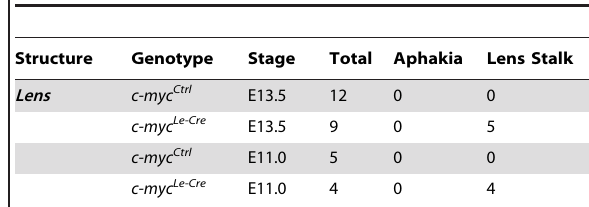
Table 2. Phenotypes of control ( c-myc Ctrl ) and c-myc- deficient embryonic lens ( c-myc Le-Cre